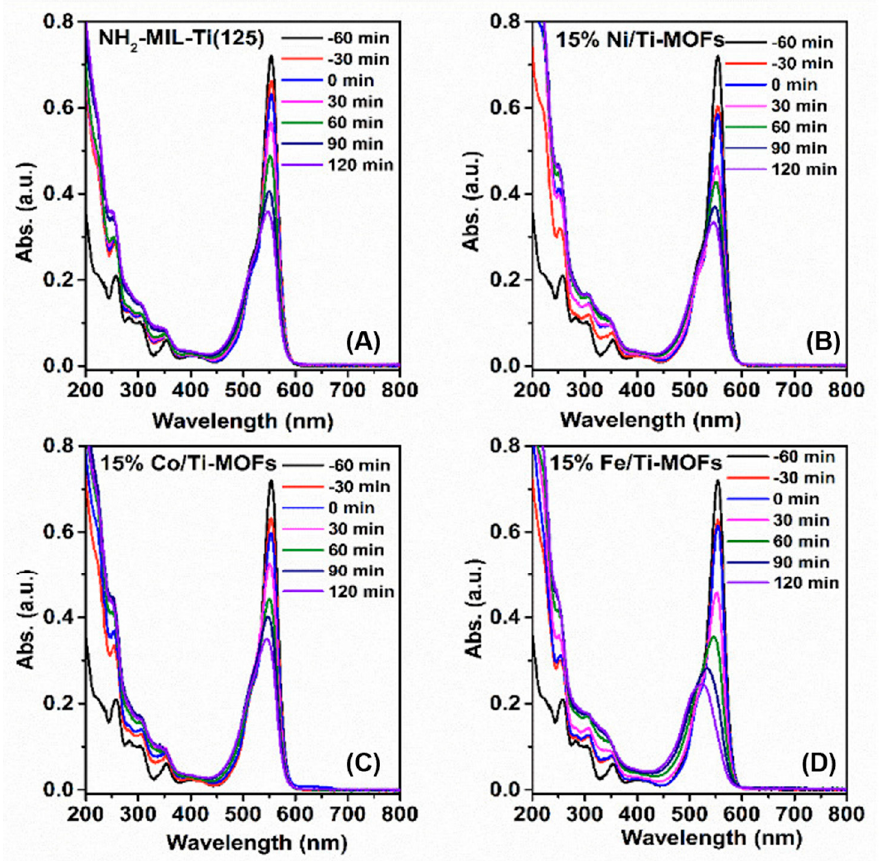
Figure 7. UV-Vis absorption spectra of RhB with respect to irradiation time over ( A ) NH 2 -MIL-125(Ti), ( B ) 15% Ni/Ti-MOFs, ( C ) 15% Co/Ti-MOFs, ( D ) 15%Fe/Ti-MOFs, respectively.